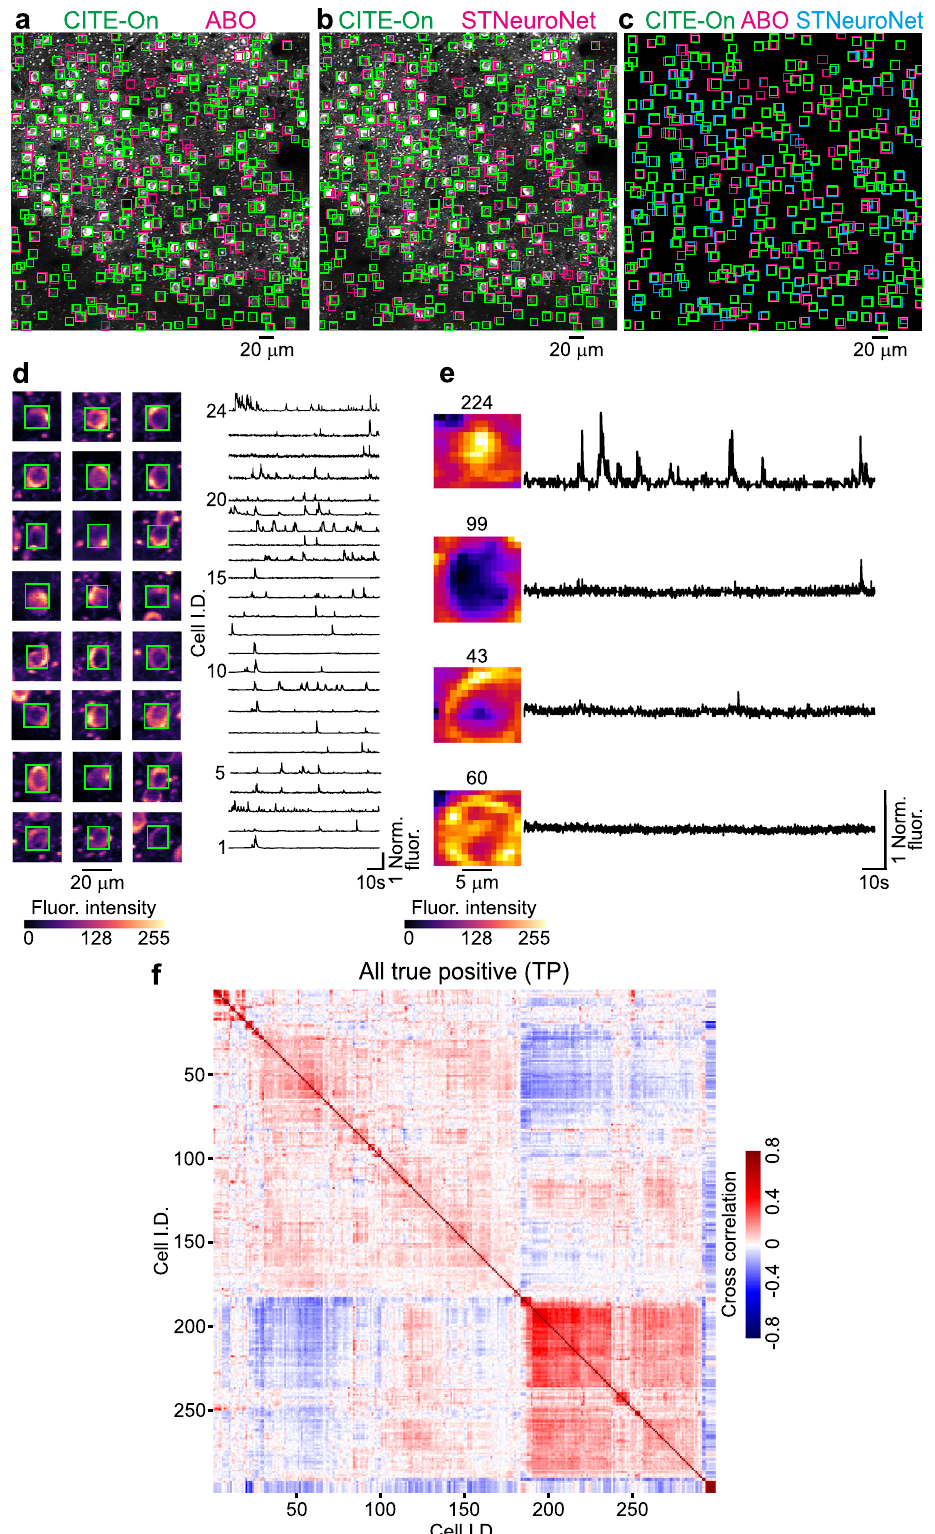
Table 4). The F-1 score calculated online as a function of